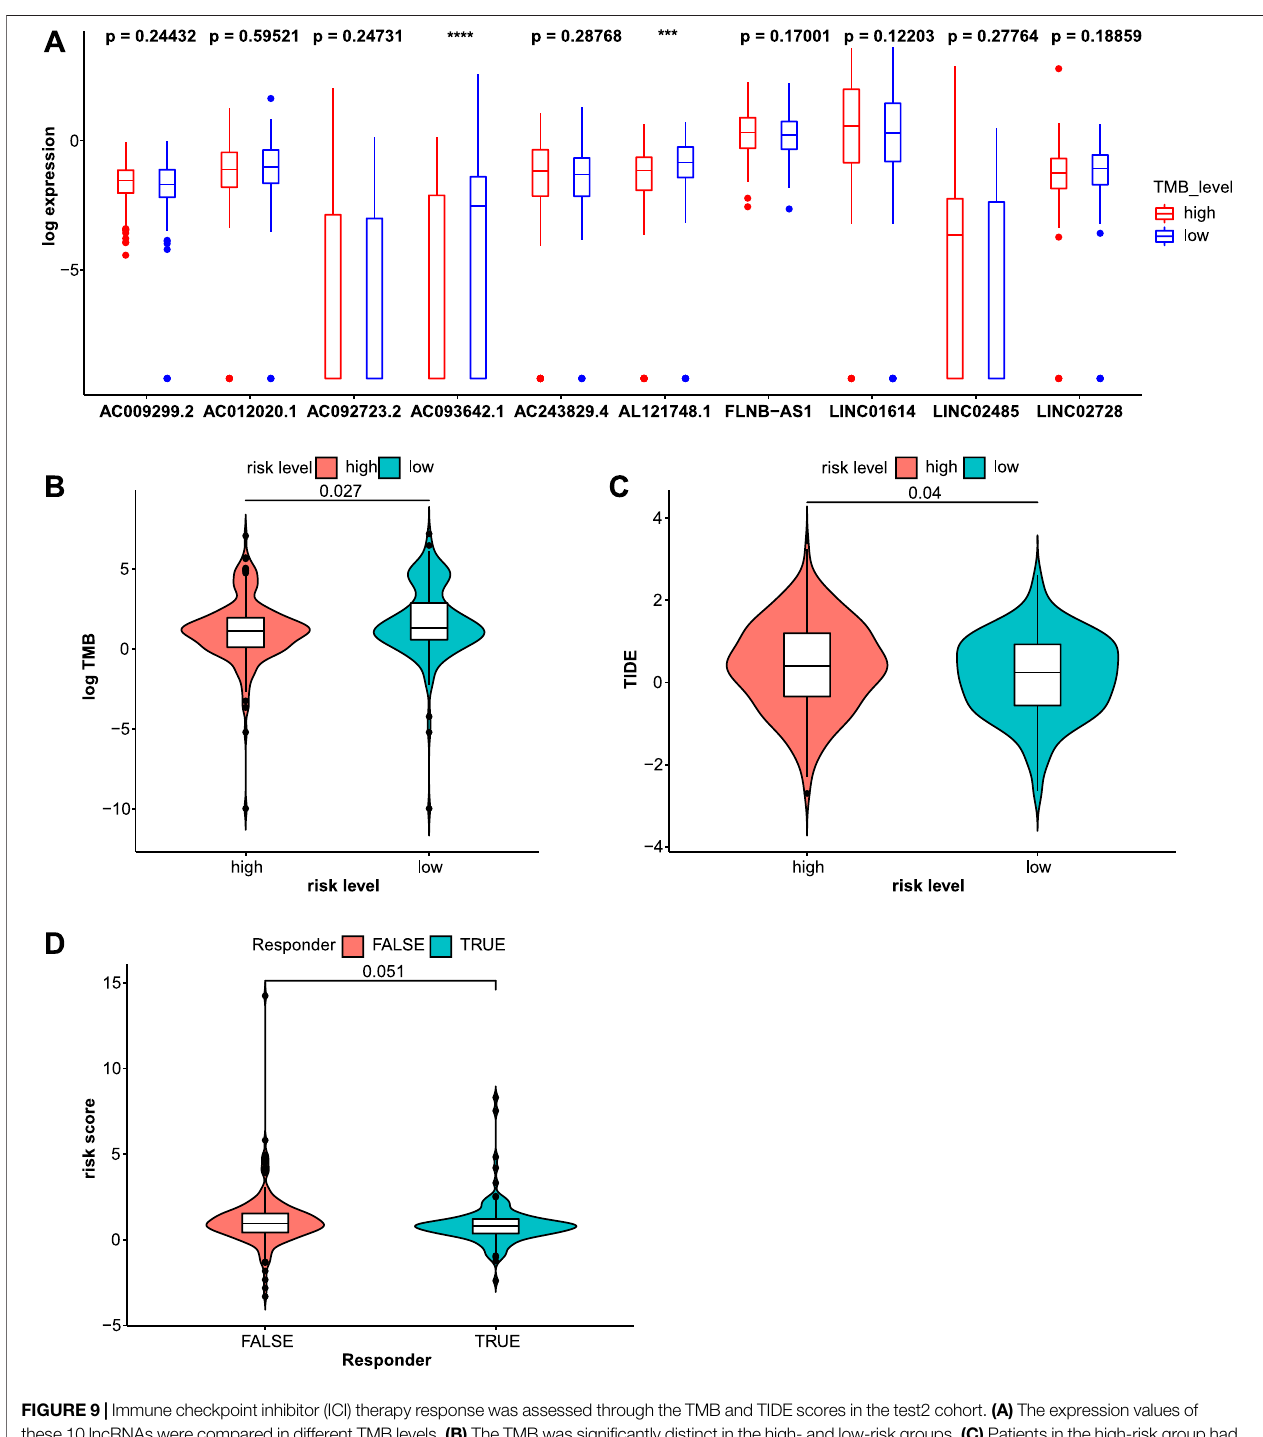
lncRNAs was constructed and patients with stomach cancer were divided into two risk groups based on risk scores. Patients in the low-risk group had a longer overall survival time than those in the high-risk group.